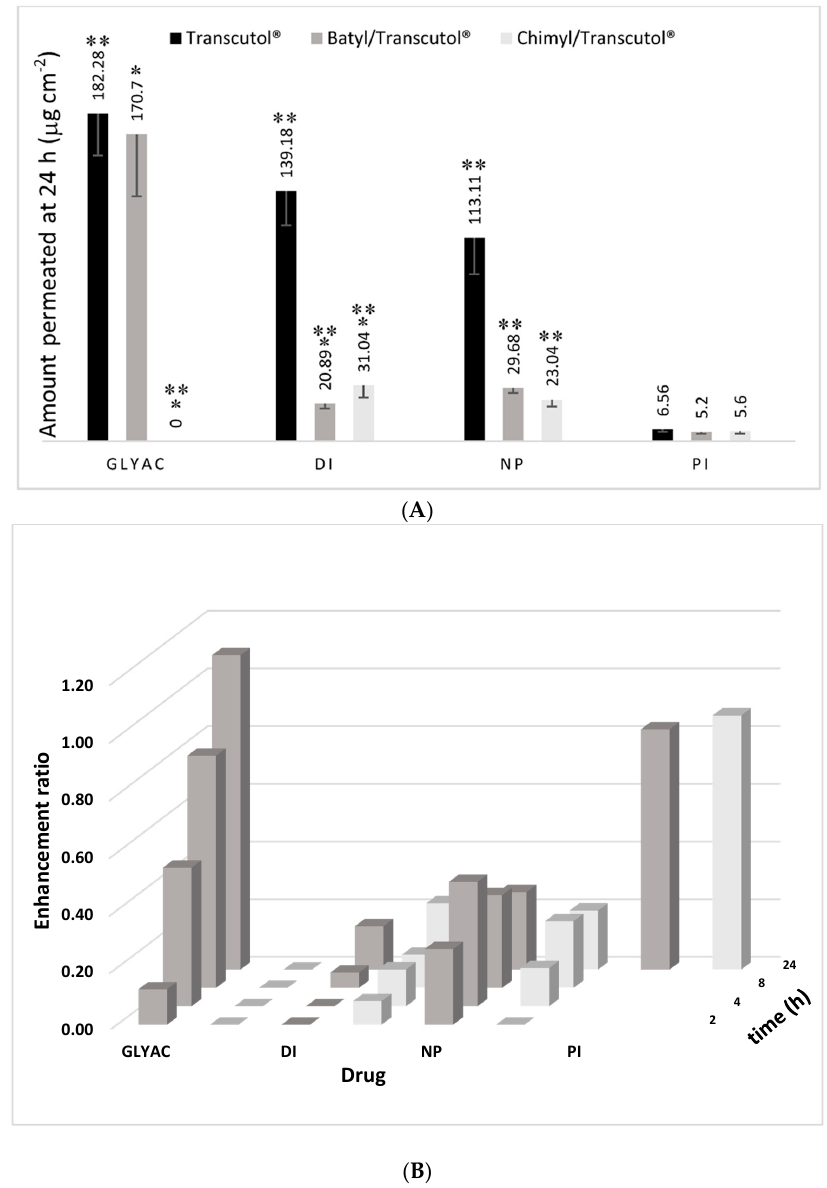
Figure 3. Comparison of the effect of batyl and chimyl alcohols: ( A ) On the total amount permeated (µg·cm − 2 ) after 24 h. * p < 0.05 (batyl vs. chimyl); ** p < 0.05 (Transcutol ® vs. batyl or chimyl) by comparing each drug separately. ( B ) On the enhancement ratios at different times. Enhancement ratio = Amount permeated with alkylglycerol/Amount permeated without alkylglycerol. Transcutol ® ; Batyl alcohol/Transcutol ® ; Chimyl alcohol/Transcutol ® . GLYAC = glycyrrhizic acid; DI = diclofenac; NP = naproxen; PI = piroxicam. p < 0.05 for batyl vs. chimyl for all the times, with the exception of 24 h for DI, NP, and PI.